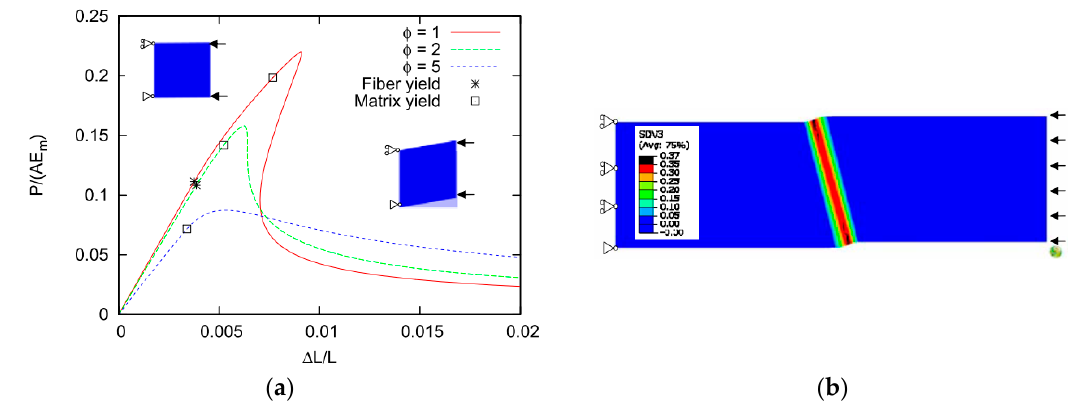
Figure 7. Smeared out finite element modeling of the fibre reinforced polymer matrix composite. ( a ) Smeared out material behavior; ( b ) Kink-band formation with yielding zone.